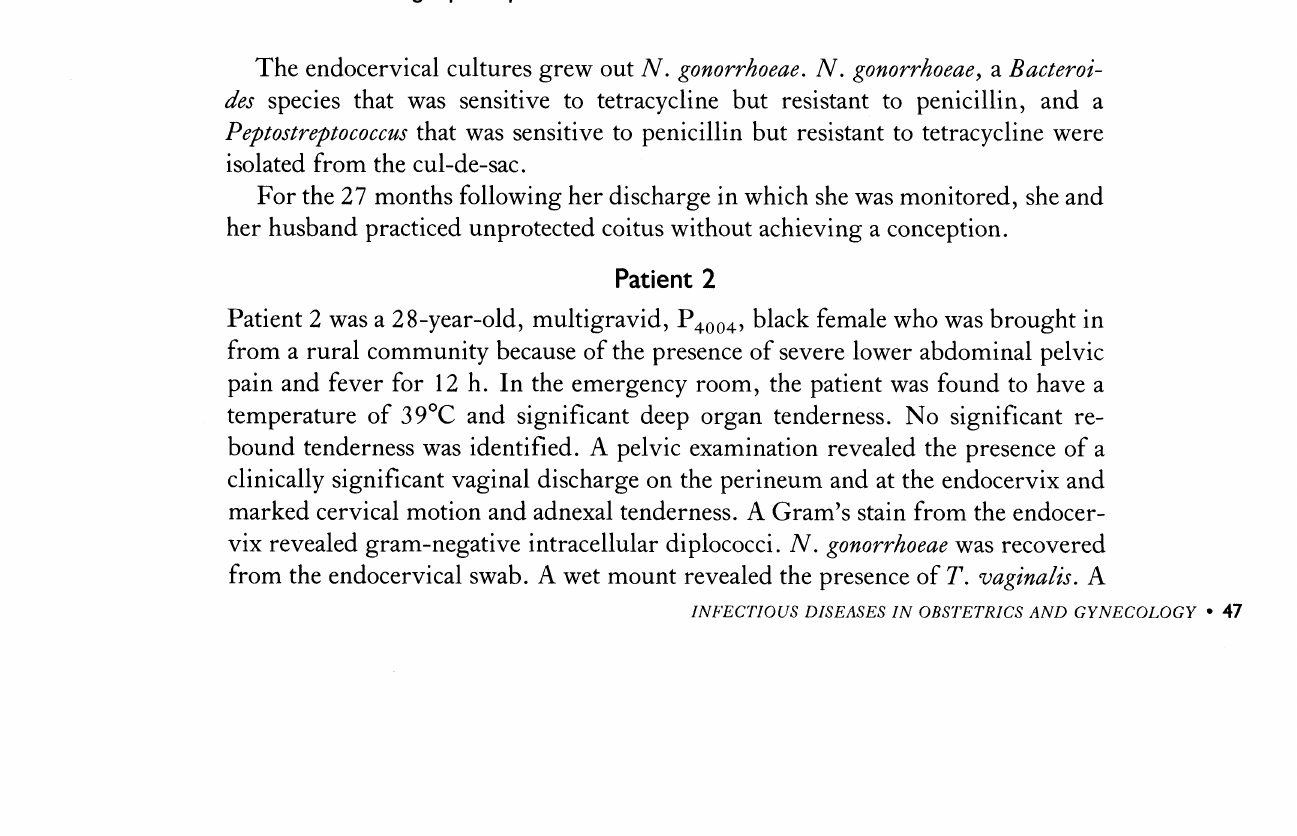
Fig. I. Temperature chart of a patient with gonococcal endocervici- tis and gonococcal polymicrobial peritonitis. After the initial lysis of fever, the patient had a prolonged temperature elevation due to super- infecting